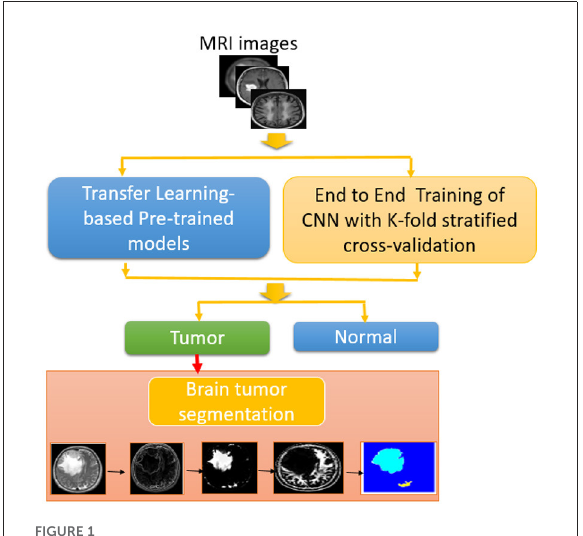
FIGURE1 Block diagram of proposed methodology for brain tumor detection and